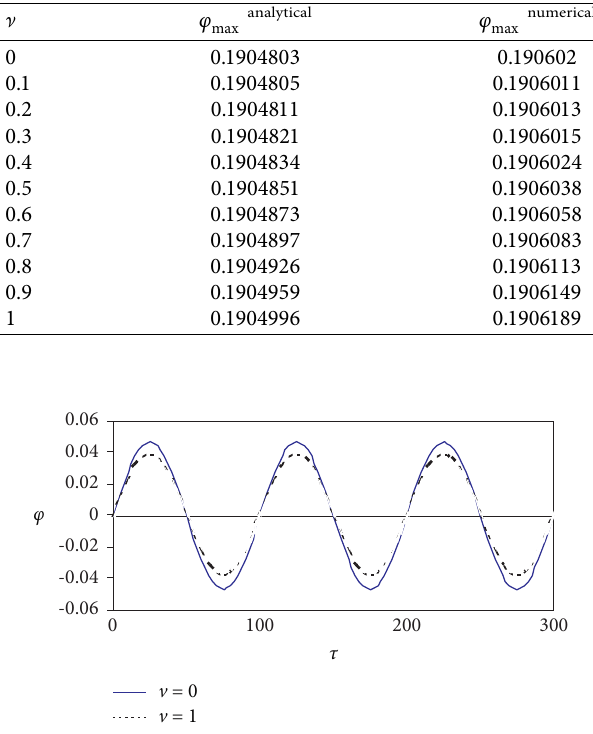
Table 5: φ of the fifth case ( Ω � 2 . 5 , μ � 1250 ) . max